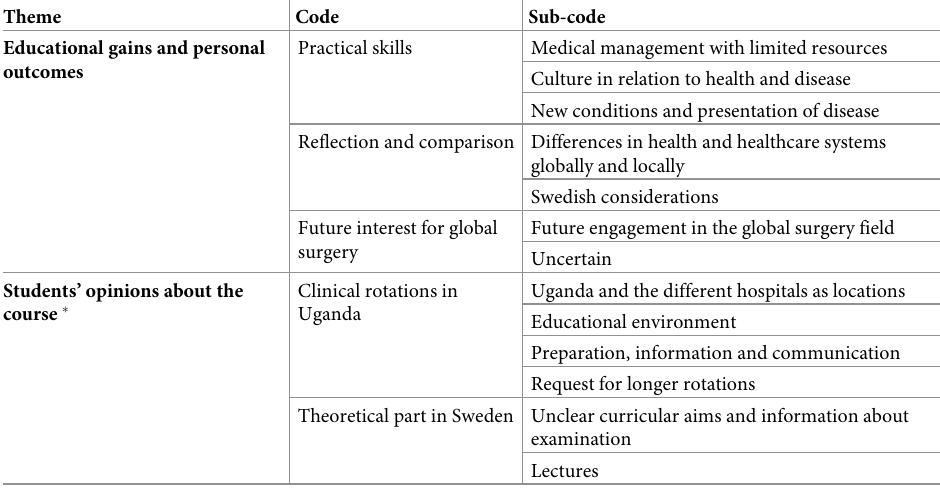
Table 1. The coding tree of course evaluation short-answer